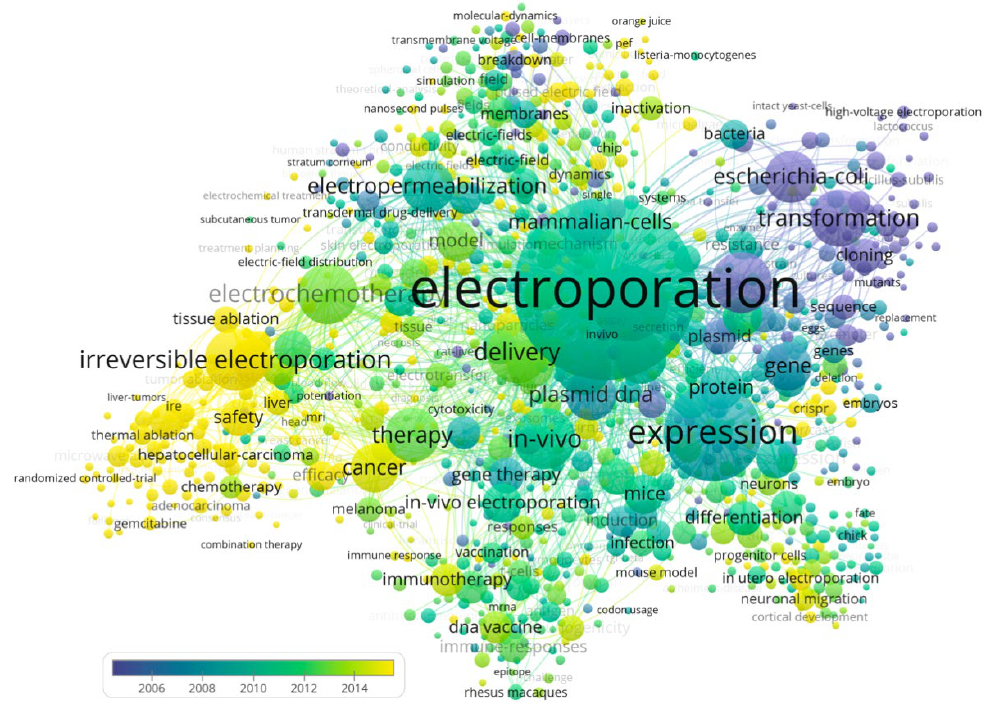
Figure 1. The co-occurrence of electroporation-based topics and keywords in scientific publications (source: Clarivate Analytics Web of Science; keyword: “electroporation”; access date: 26 February 2023). Processed using VOSviewer, version 1.6.18 (Leiden University). Larger circle size corresponds to a higher rate of occurrence of a keyword.